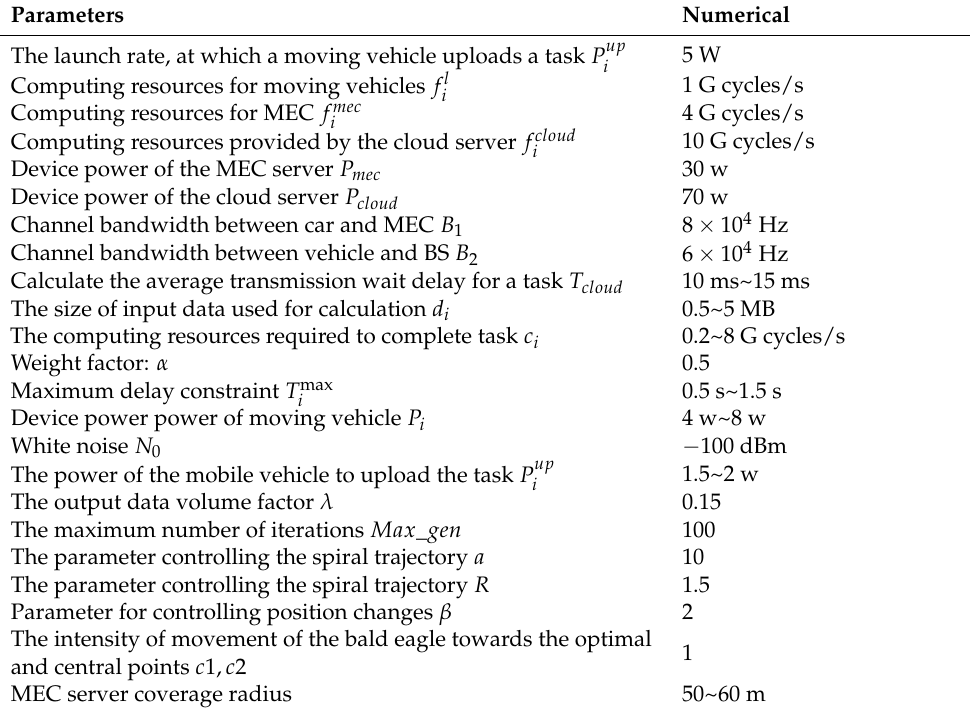
Table 2. Simulation